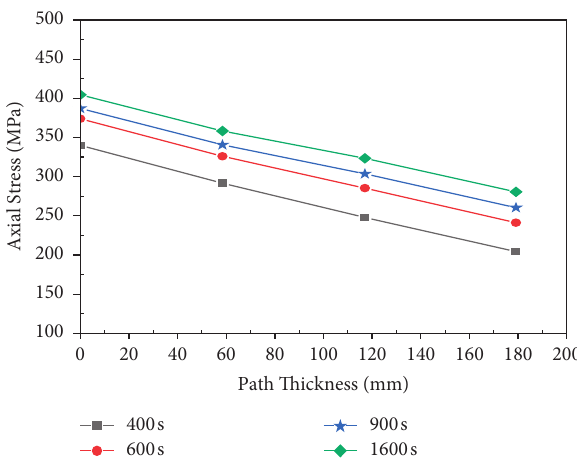
Figure 9: Axial stress variation along the inlet nozzle-inside vessel wall intersection thickness of the FE model.